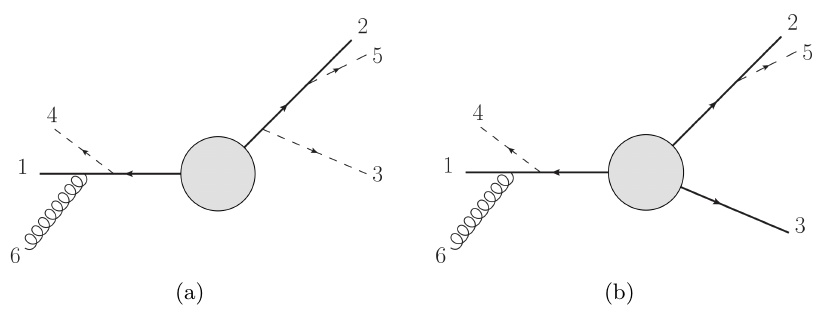
Figure 6 . Diagrams illustrating substitution (3.37) in the case of six coloured particles. These particular contributions correspond to a term ∼ (5) S 2 , 3 E 2 Θ( θ 16 < θ 25 ) d(cos θ 16 ) . Solid lines are 6 1 coloured particles from the hard process and dashed lines are showered partons, ordered in angle. Diagram (a) has two hard partons (a two-jet process), whilst (b) has three hard partons (a three-jet process). The emission probability is the same for both, modulo momentum conservation and recoil against parton 3 , which is not necessarily hard in (a). For a discussion on momentum conservation see the text surrounding eq. (3.41). This is in contrast to an angular-ordered shower, where (a) and (b) are handled differently from each other